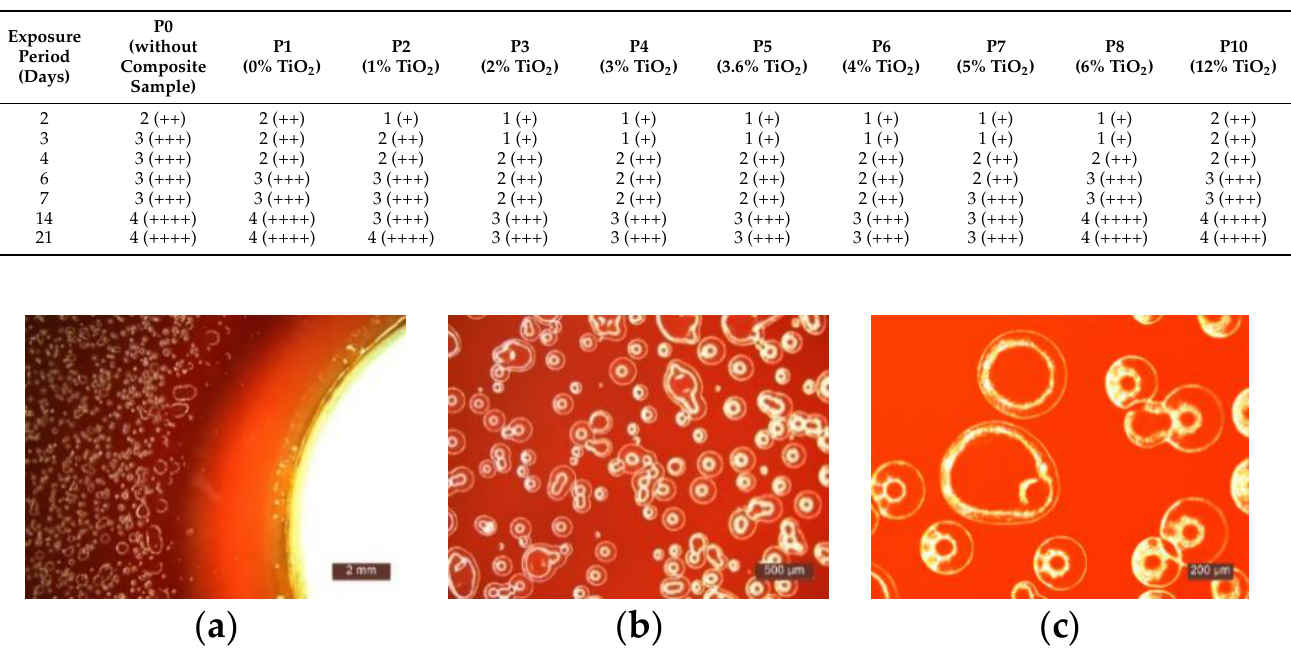
Table 6. Quantification of the microbiological load of the system according to STAS 12718 for samples exposed to Streptococcus Pyogenes .